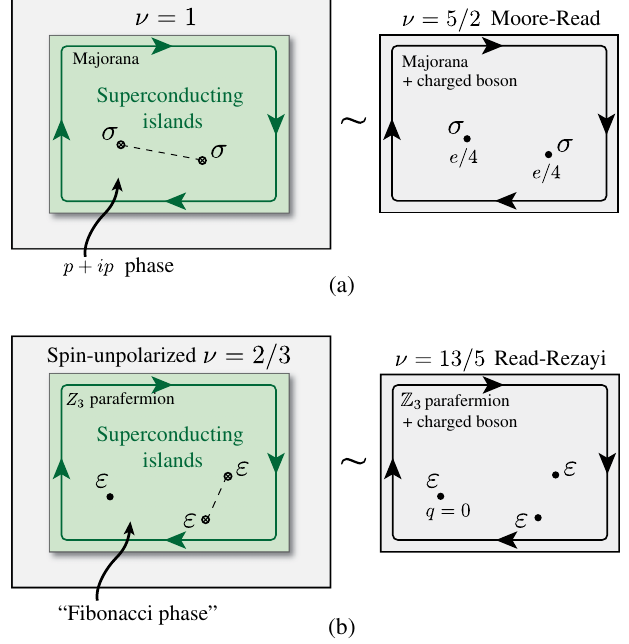
FIG. 1. Abelian quantum Hall states interlaced with an array of superconducting islands (left column) realize analogues of exotic non-Abelian quantum Hall states (right column). The interface between the superconducting regions and surrounding Abelian quantum Hall fluids supports chiral modes similar to those on the right, but without the bosonic charge sector. (We suppress the edge states at the outer boundaries of the Abelian quantum Hall states for simplicity.) Solid circles denote deconfined non- Abelian excitations, while open circles connected by dashed lines represent confined h= 2 e superconducting vortices. Quasi- particle charges are also listed for the non-Abelian quantum Hall states. In (a), σ particles represent Ising anyons, which in the p þ ip phase on the left correspond to confined vortex excita- tions. In (b), ε is a Fibonacci anyon that exhibits universal braid statistics. The superconducting Fibonacci phase is topologically ordered and supports deconfined ε particles — similar to the Read- Rezayi state. Vortices in this nontrivial superconductor do not lead to new quasiparticle types, but can, in principle, trap Fibonacci anyons and/or